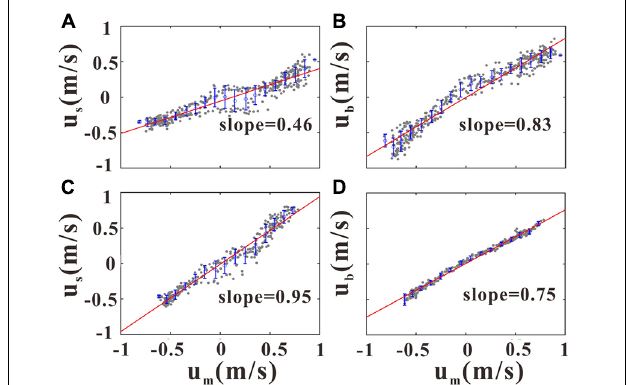
FIGURE 8 | Scatterplots of u m vs. u s at GJ-01 and GJ-02 (A,C) and u m vs. u b at GJ-01 and GJ-02 (B,D) . Gray dots indicate 10-min average data of raw streamwise velocities ( u ) at the three representative layers, and blue circles and error bars represent bin-averaged u b values over an interval of 0.1 m/s along the x -axis and associated standard deviations. The red lines are obtained by the linear fitting of u data shown by gray